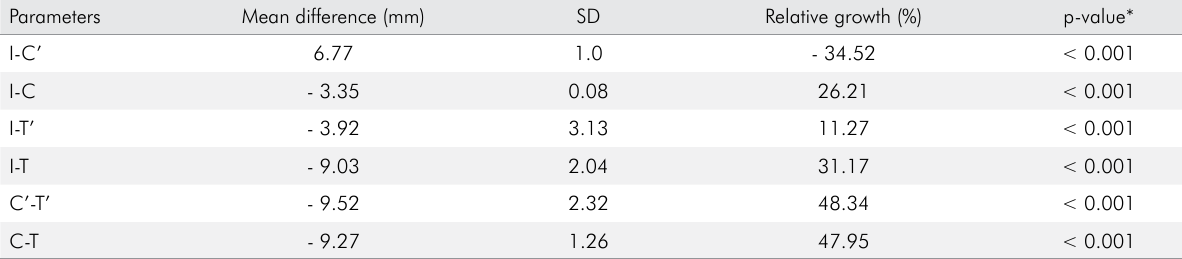
Table 1. Mean growth differences and relative growth percentage in the evaluated period (paired t test). Parameters